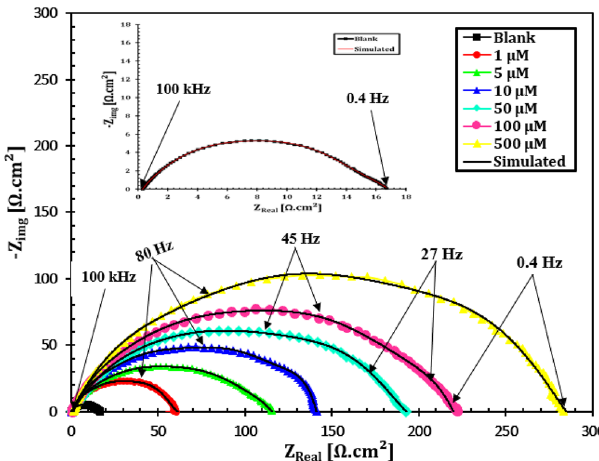
Figure 7. Nyquist plots of C-steel in 1 M HCl with different concentrations of inhibitor MA-1740 at 25 °C.